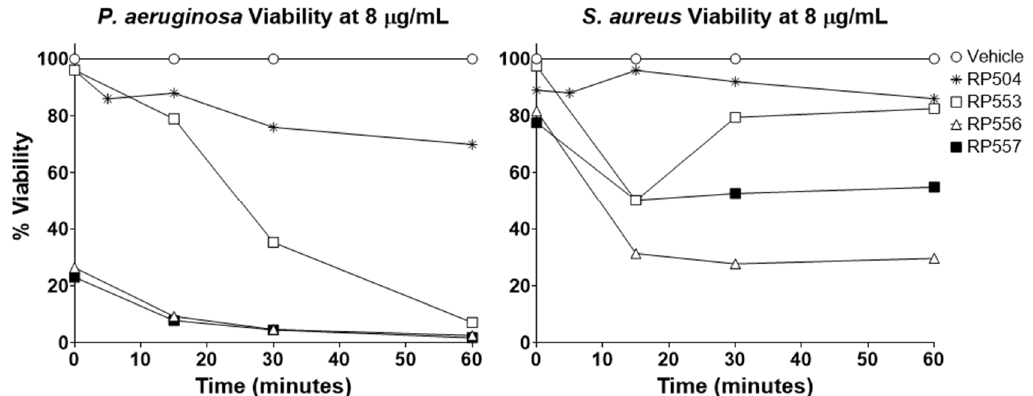
Figure 3. RP553, RP556, RP557 rapidly destroy P. aeruginosa and S. aureus. The bioluminescence of viable P. aeruginosa 19,660 and S. aureus 49,525 cells was quantitated in real time with an IVIS Lumina bioimaging system. Data represent the mean ± SE of triplicate replicates from two independent experiments. For some points, the error bars are shorter than the height of the symbols.